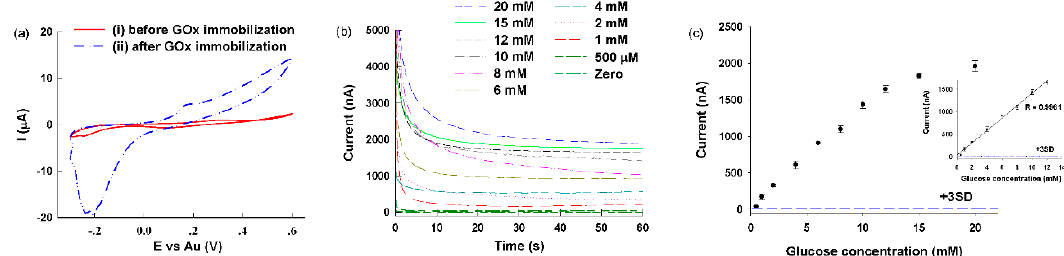
Figure 3. ( a ) Cyclic voltammograms obtained (at a scan rate of 50 mV/s) in a PBS solution containing 5 mM glucose (i) before GOx immobilization and (ii) after GOx immobilization on the Au plated PCB surface. ( b ) Amperometric response of GOx modified PCB biosensor with 0–20 mM glucose in PBS. ( c ) Calibration plot of glucose concentration based on chronoamperometric currents at 60 s from the response profile in panel a. Each data point represents the mean ± SD of three separate measurements obtained using new sensors. Inset shows a magnified view of the data points at 500 µM to 12